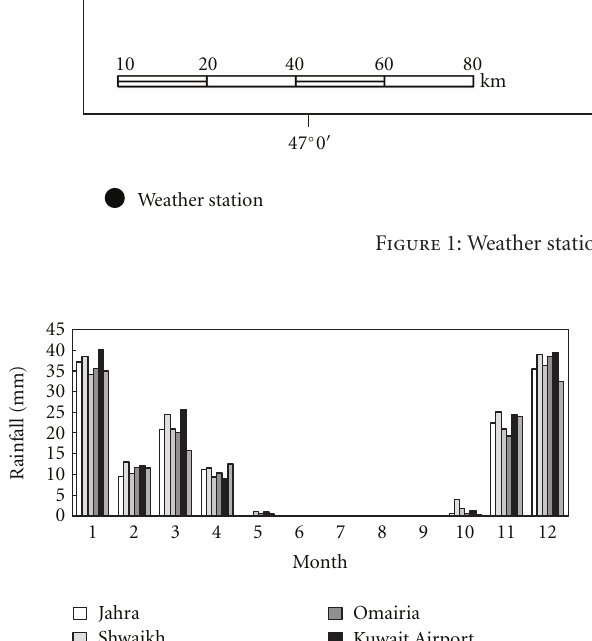
so large relative to the size of the data by which there would be no su ffi cient oscillating movement repetitive over the time